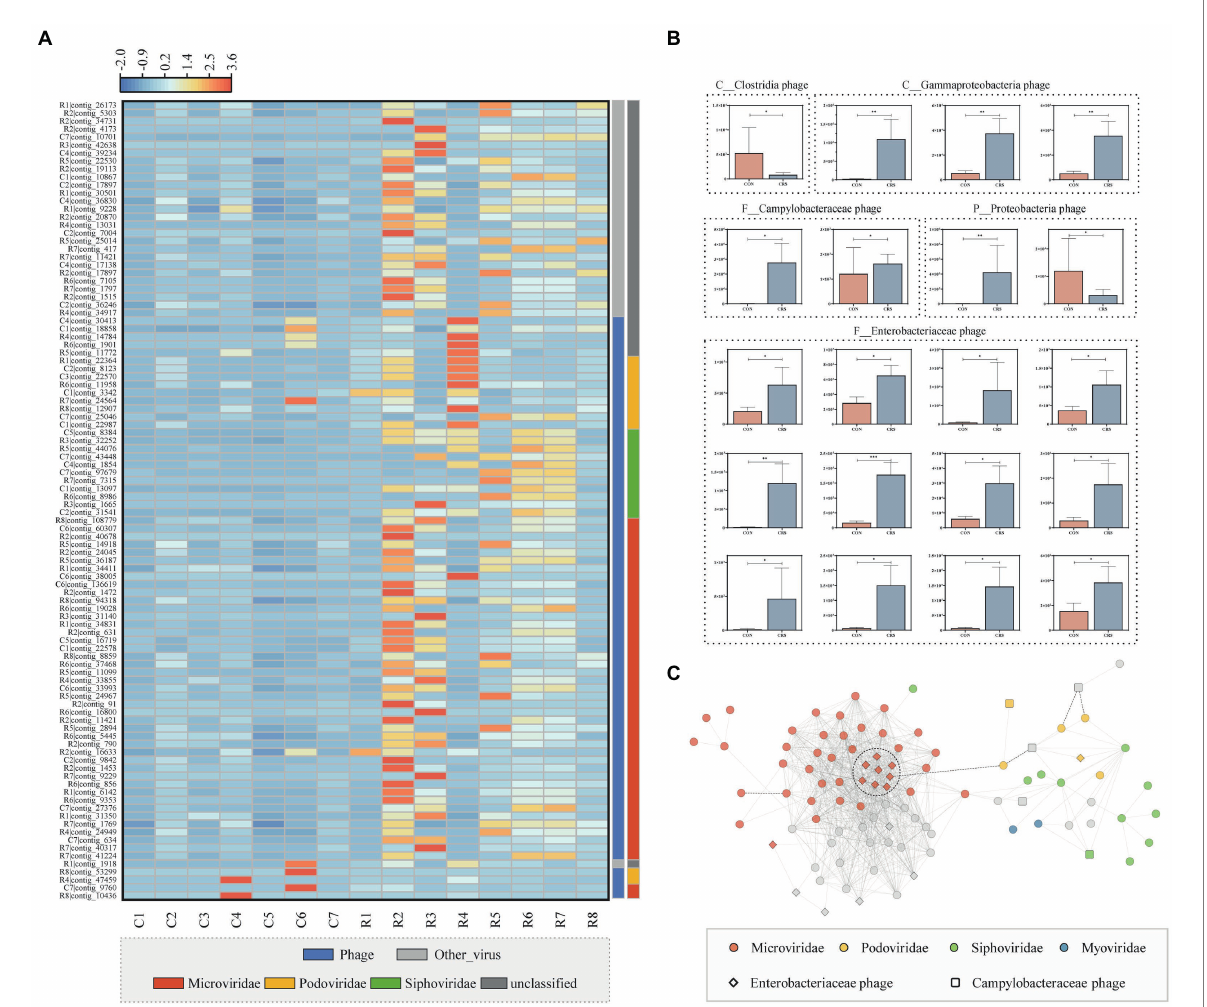
FIGURE 3 Differential viral profile and the correlations between the differential virus contigs of the two groups. (A) Heatmap of the differential virus contigs (the top 100 of relative abundance); the color scale bar shows z-score values after z-score row normalization. (B) Bar plot of 20 differential viral contigs, of which the potential bacterial hosts were predicted. The data are represented as the mean ± standard errors of the means (SEM). * p < 0.05, ** p < 0.01, *** p <0.001. (C) The differential virome co-expression network with Spearman’s rank correlation coefficient (|r|>0.6, p < 0.01). Dots with different colors indicate different